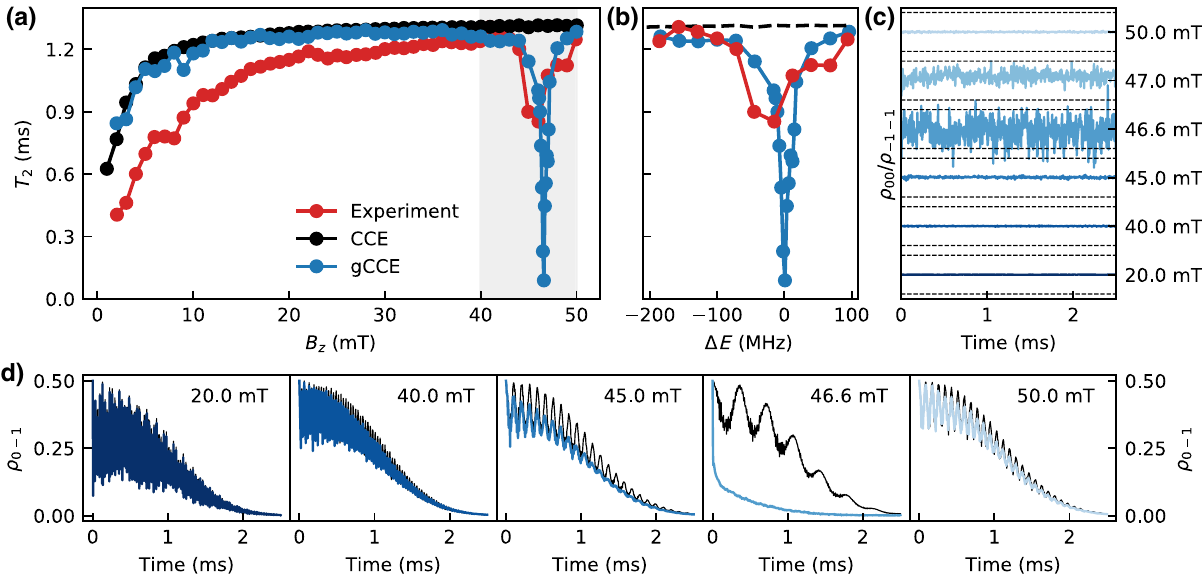
FIG. 2. Ensemble Hahn-echo coherence of the axial kk divacancy in 4 H -SiC. (a) Coherence time T 2 (blue circles) as a function of the magnetic field B z . The experimental results (red circles) and conventional CCE predictions (black circles) are from Ref. [5]. Gray shading denotes the range of T 2 shown in (b). (b) Experimental (red circles) and predicted (blue circles) coherence times T 2 as a function of energy splitting between qubit levels. The black line shows the pure dephasing results. (c) The oscillations in the ratio of the diagonal elements of the density matrix of the divacancy as a function of time for various values of the magnetic field. The dashed lines show the ± 2% range. (d) The off-diagonal elements of the density matrix for different magnetic fields computed using the gCCE method with Monte Carlo sampling of the bath states (color) and using the conventional CCE method